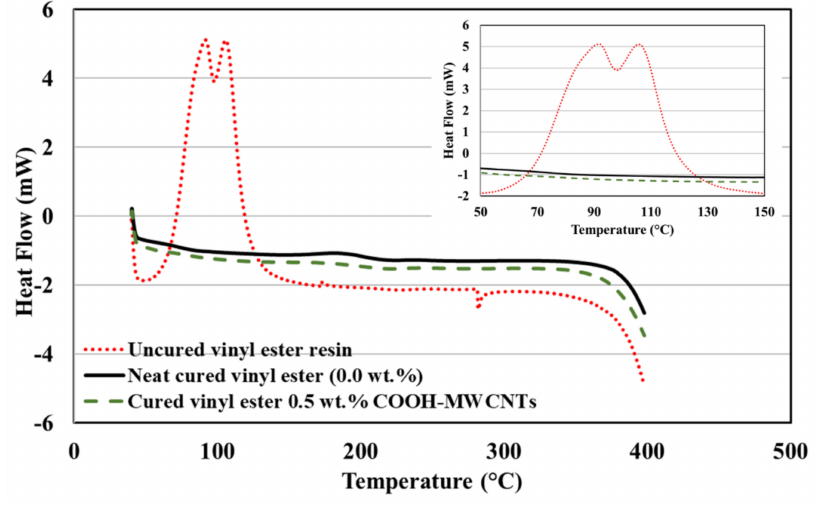
Figure 7. Di ff erential scanning calorimetry graphs for uncured neat vinyl ester with MEKP, neat cured vinyl ester, and cured vinyl ester incorporating 0.5 wt.% COOH-MWCNTs. The inset figure shows a close look at the behavior of the three materials at the peak heat flow. Table 2. Normalized heat of reaction and consequent degree of cure for uncured vinyl ester, neat